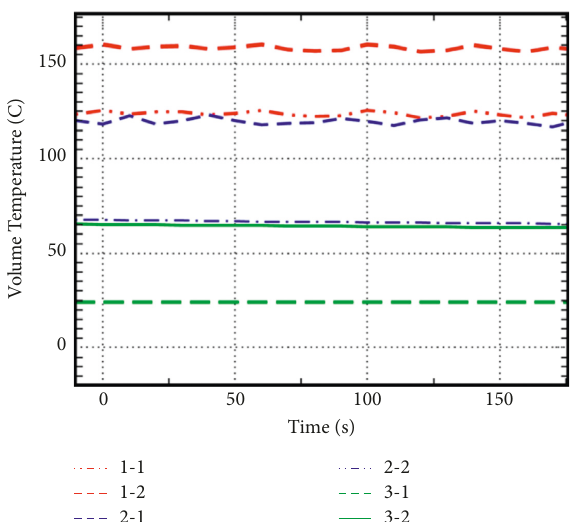
Figure 11: Fluctuations in the flow rate of the coolant in the circuits of heat removal from the core at a power of 50MW: 1-1, coolant temperature at the core inlet; 1-2, coolant temperature at the core outlet; 2-1, coolant temperature at the steam generator outlet; 2-2, coolant temperature at the steam generator inlet; 3-1, ambient air temperature at the inlet to the air heat exchanger; 3-2, atmospheric air at the outlet of their air heat exchanger.